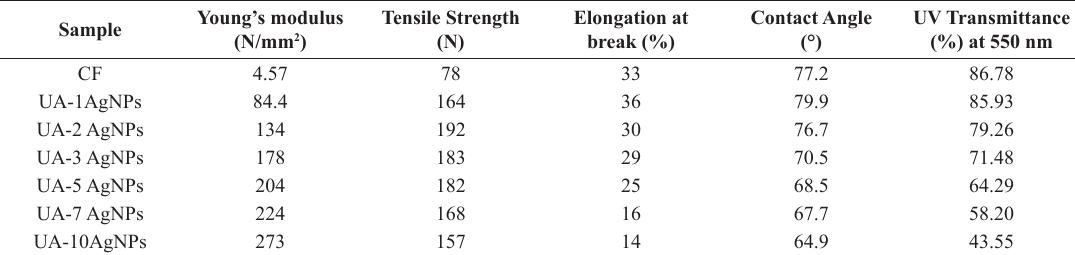
Table 3. The physical and mechanical properties of UV-cured materials.